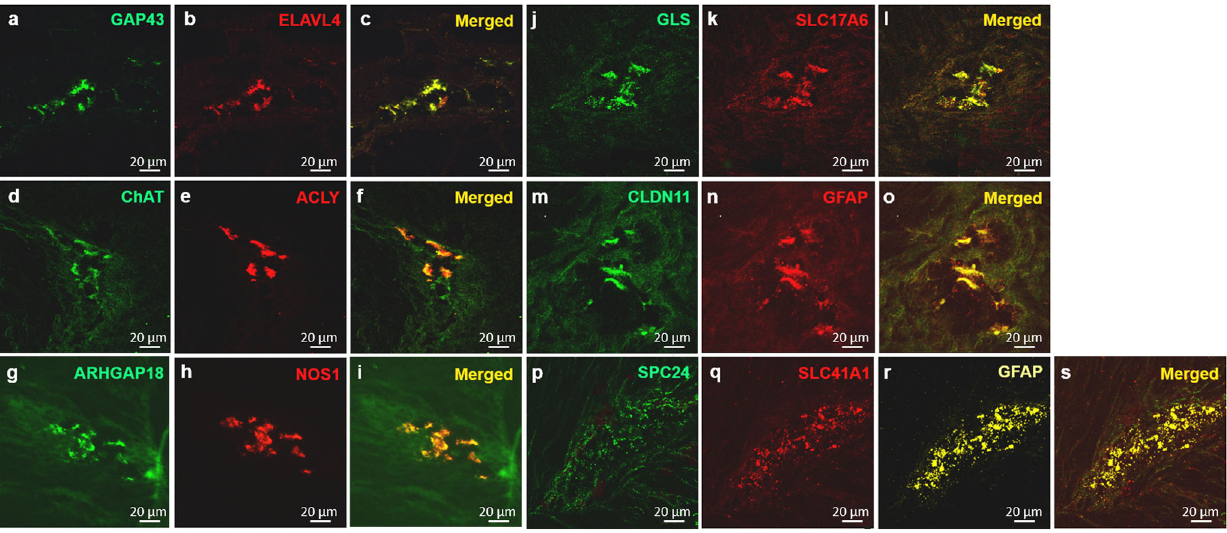
Fig. 5 Validation of discriminatory marker genes for major classes of enteric neurons and two subtypes of enteric glial cells (EGCs) in the myenteric ganglia of porcine proximal colon using RNAscope in situ hybridization. Confocal images were generated from 5 – 10 optical sections (Z-stack) cross the myenteric ganglia with frame 436 × 436 μ m and 1 μ m apart (20× objective). The co-expression of mRNA for GAP43 (annotating enteric neurons) with ELAVL4 encoding Hu C/D a , b , ACLY (annotating cholinergic neurons) with ChAT d , e , ARHGAP18 (annotating nitrergic neurons) with NOS1 g , h , GLS (annotating glutamatergic neurons) with SLC17A6 encoding VGLU2 j , k , CLDN11 (annotating EGCs) with GFAP m , n , and SPC24 , SLC41A1 (annotating two subtypes of EGCs) with GFAP p , q , r were indicated in the merged images c , f , i , l , o and s , respectively. Scale bars: 20 µ